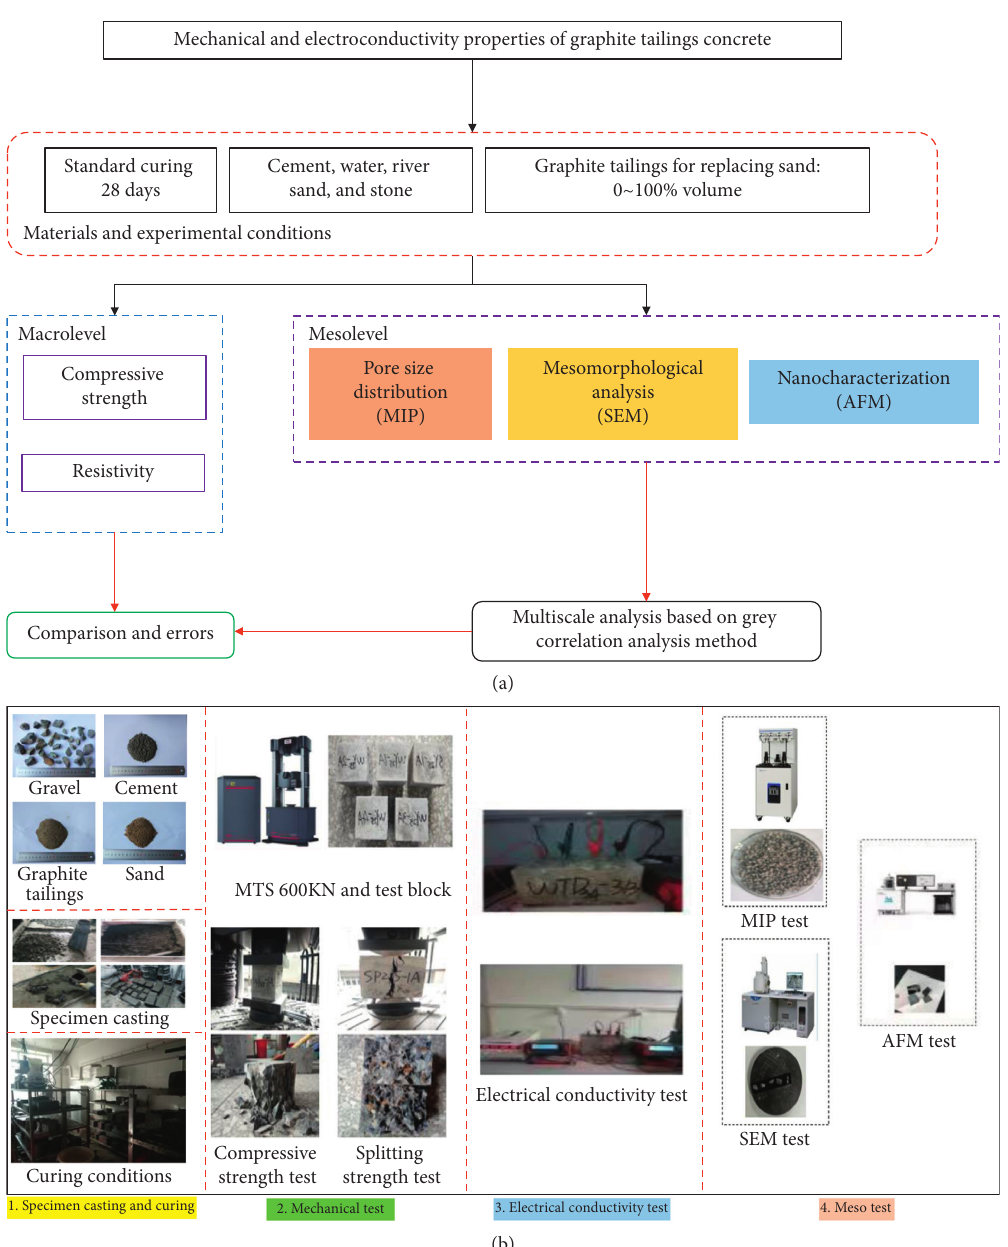
Figure 2: (a) Research flowchart and (b) experimental